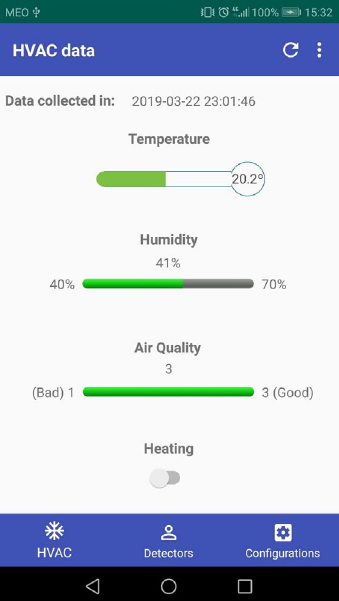
Figure 4. Example of values presented on the HVAC screen of the developed mobile app.